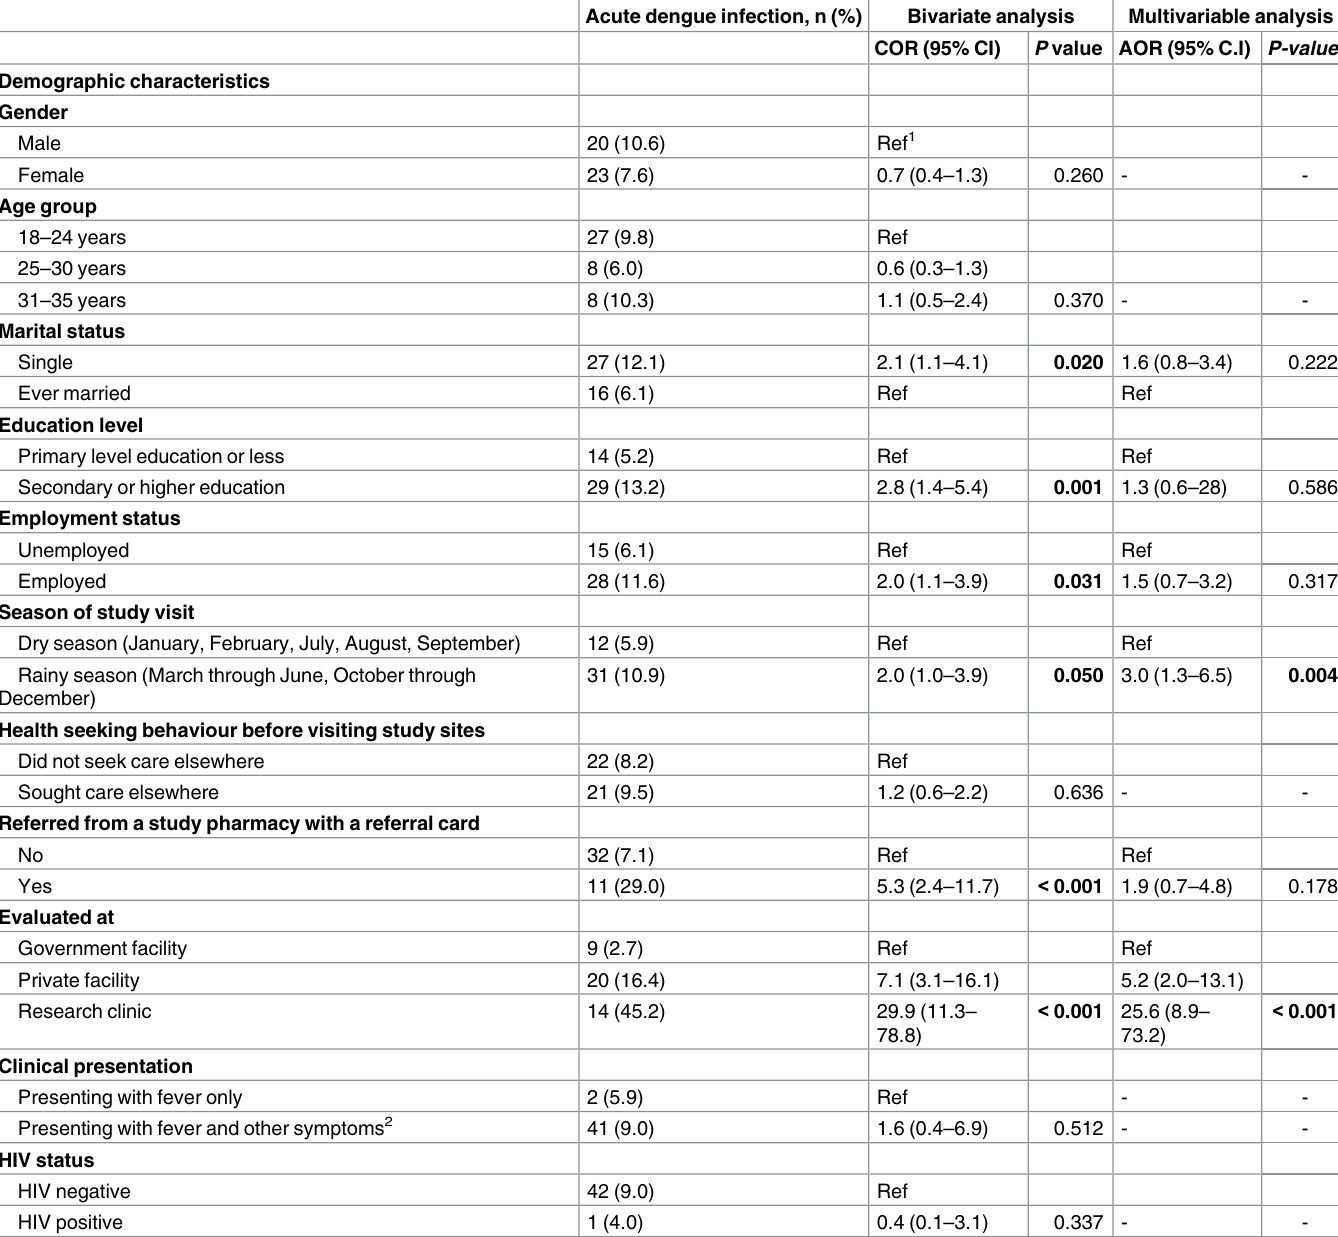
Table 2. Bivariate and Multivariable analysis of demographic and clinical characteristics of febrile patients with dengue virus infection aged 18–35 yearsseeking care in Mtwapa or Kilifi, February 2014- January 2015 (N = 489). Acute dengue infection, n (%) Bivariate